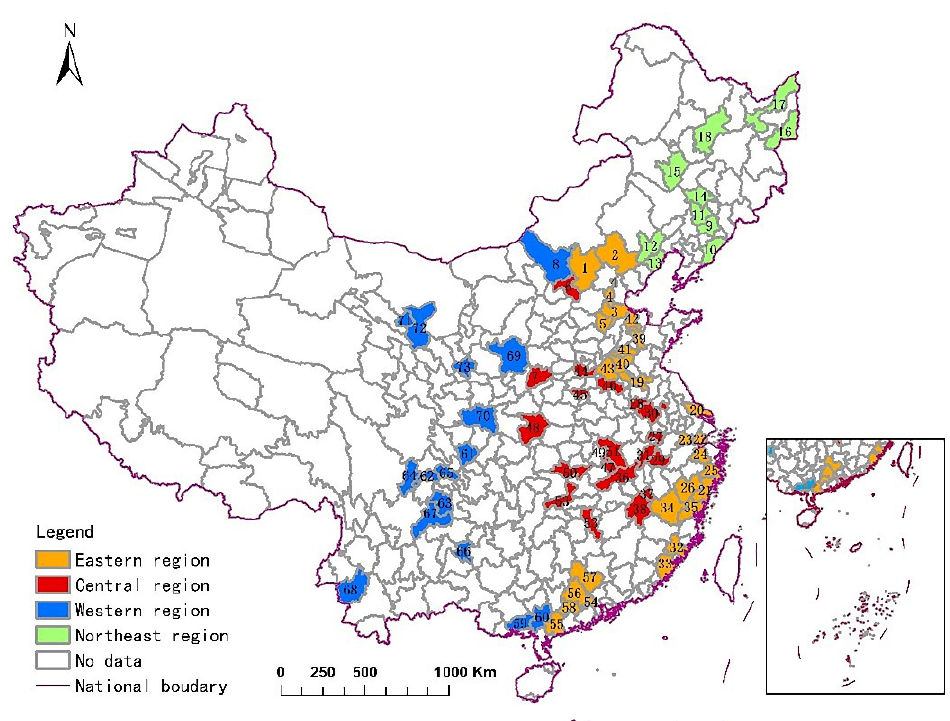
Figure A1. The city locations discussed in this paper (see the city names in the Appendix A).